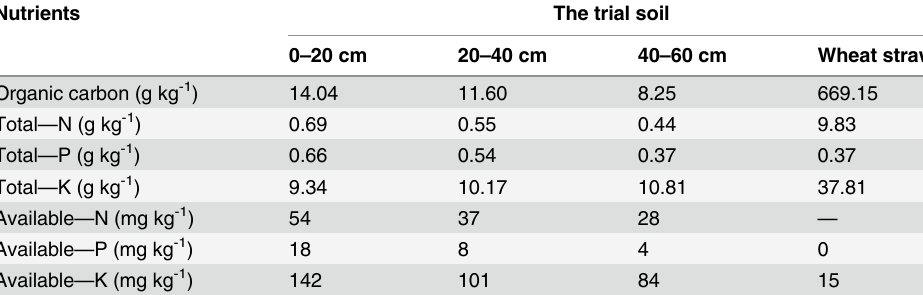
Table 1. Organic carbon and nutrient contents of the trial soil and wheat straw in 2007.